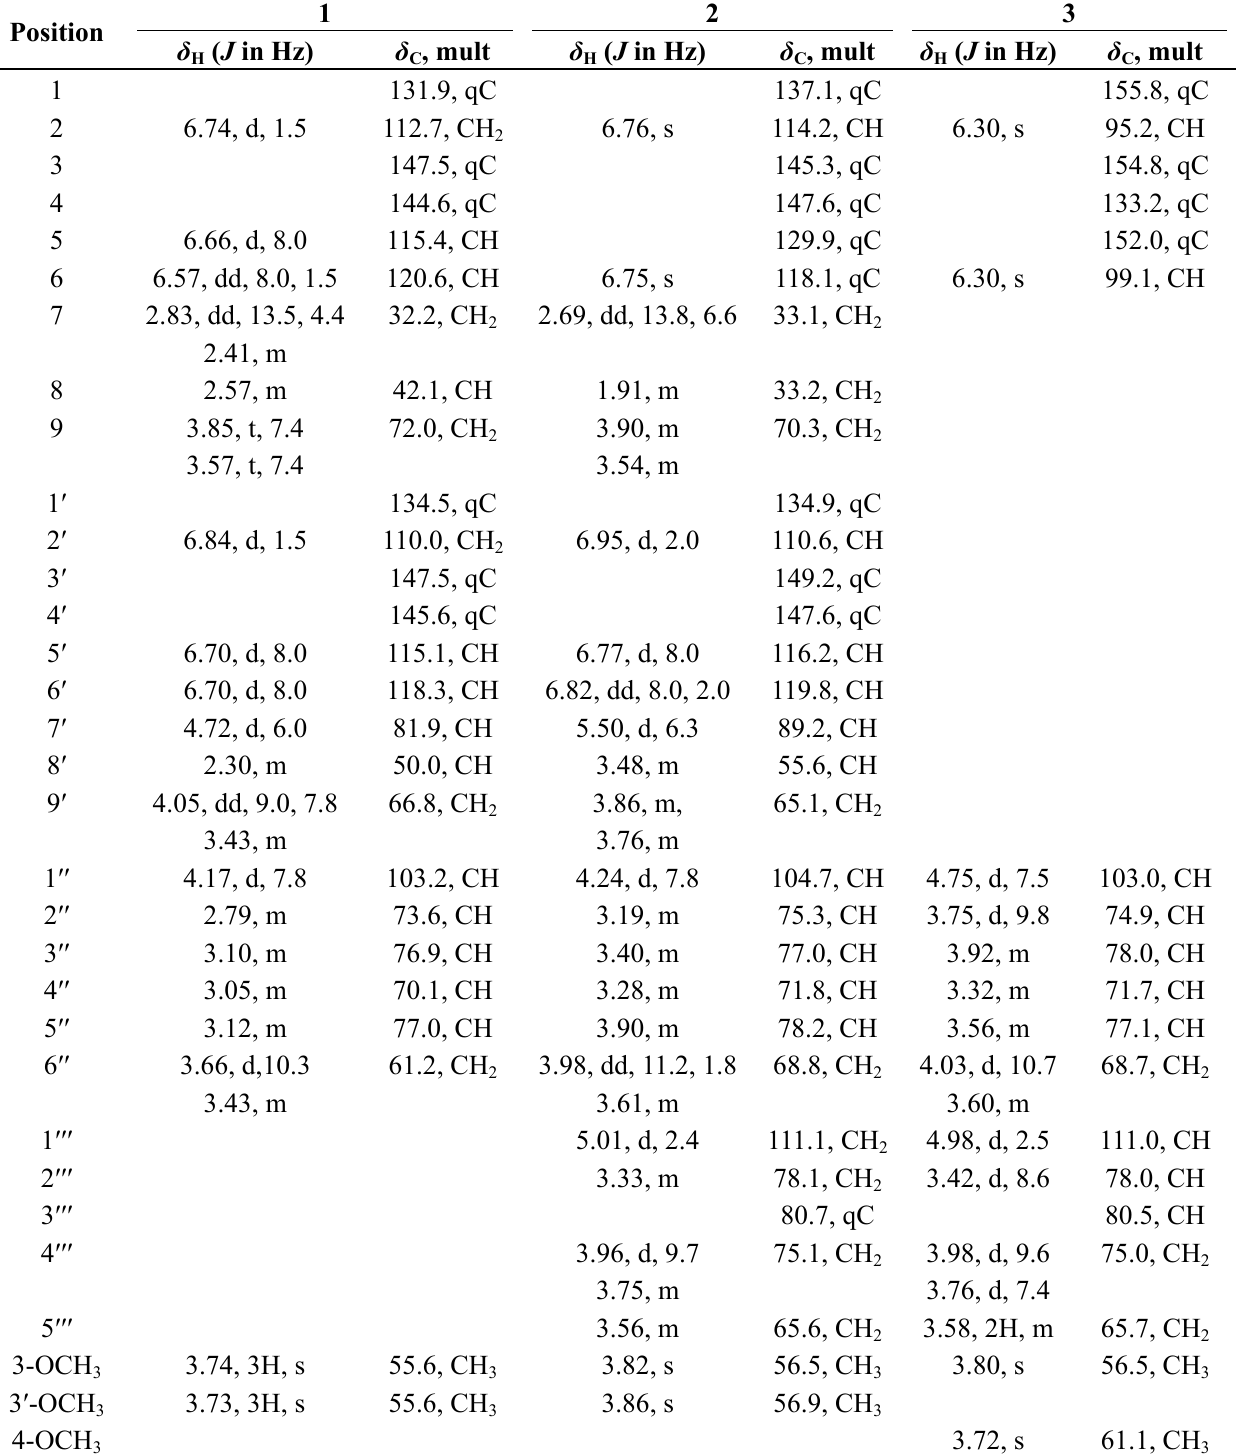
Table 1. The 1 H and 13 C-NMR spectroscopic data of 1 − 3